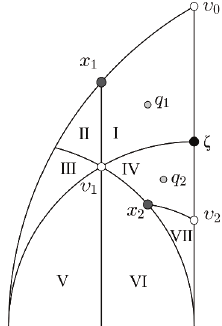
Figure 7. Regions used in Lemmas in Section 4. All the lines in the set are geodesic lines of the Poincaré half-plane. Points q √ q i make an orbit with exactly two 23 2 = 5 12 + 12